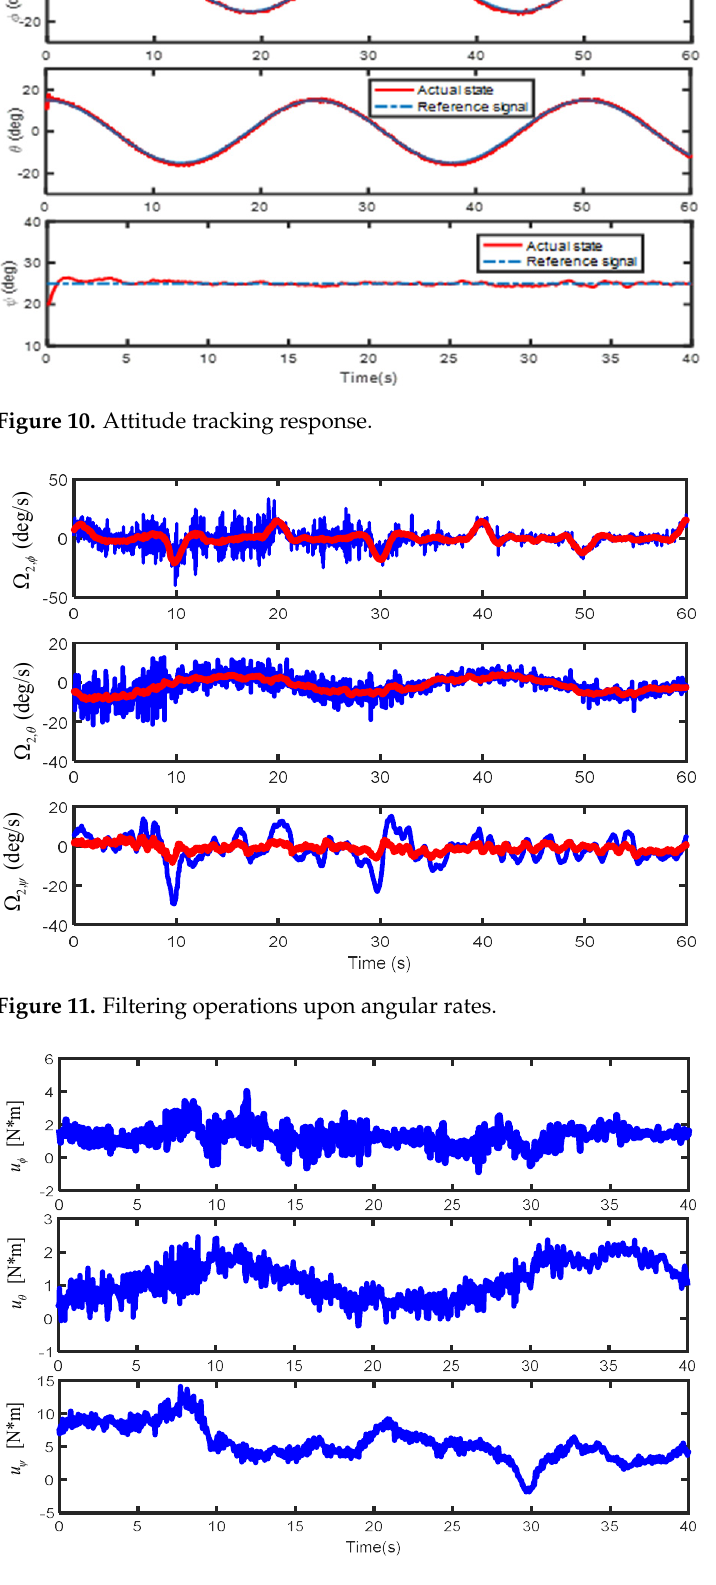
Figure 12. Control Figure 12. Control inputs.